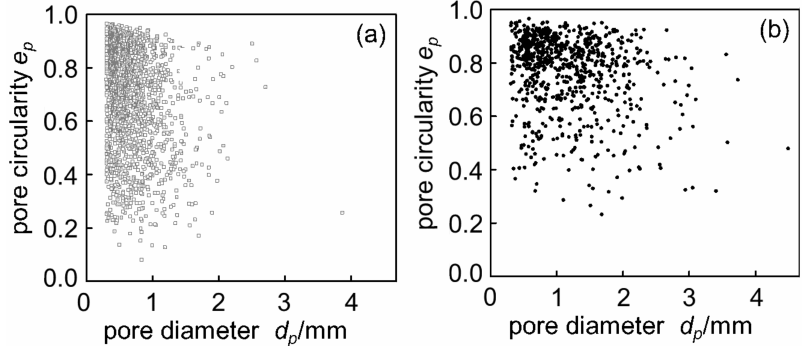
Figure 5. Distribution map of pore circularity: ( a ) Melt-A2024 ( p = 61%); ( b ) Semi-A2024 ( p = 59%).